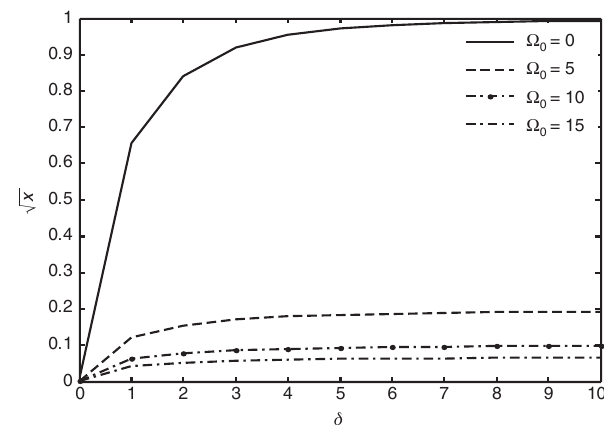
Figure 2: Variations of non-dimensional phase speed ( ) x against non-dimensional constant δ for impedance parameters δ